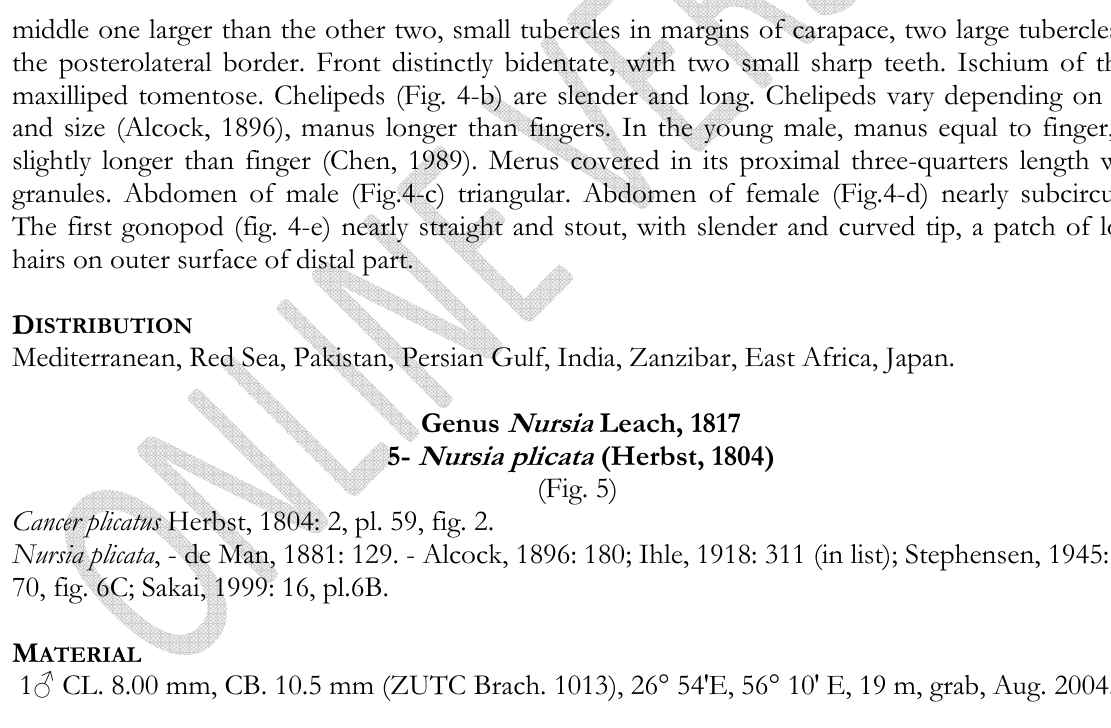
5._ Nursia plicata (Herbst, 1804): a, carapace; b, F IG . abdomen of male; c, first gonopod Scales: a & b, 5mm; c, 1